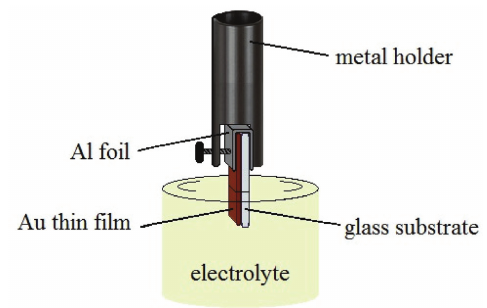
Figure 2. A scheme of the Au thin film on glass during the electroc- hemical